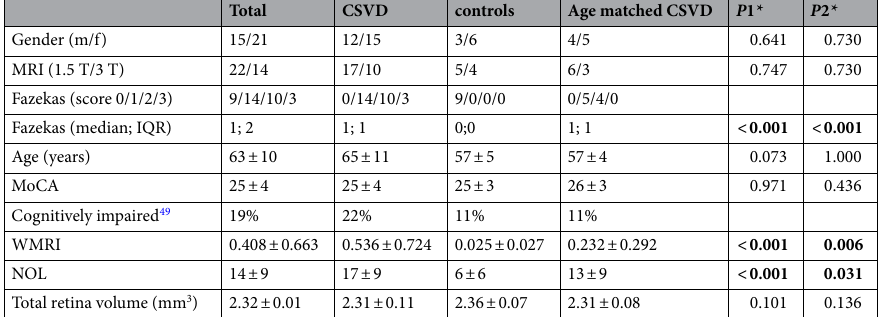
Table 1. Demographic variables and imaging parameters of patients and controls. Values are mean ± SD and the volume of the retina corresponds to the foveal and parafoveal volumes (3-mm-circle). *Mann–Whitney-U- test was performed to compare the groups. P1, comparison between all patients and controls; P2, comparison between age matched patients and control. Significant results ( p < 0.05) are displayed in bold. CSVD, patients with cerebral small vessel disease; MRI, device used for MRI imaging; 1.5 T, Philips Ingenia 1.5 T; 3 T, Achieva TX 3 T, m, male; f, female; Fazekas, Fazekas score; IQR, interquartile range; MoCA, Montreal Cognitive Assessment; WMRI, white matter lesions volume ratio index; NOL, number of white matter